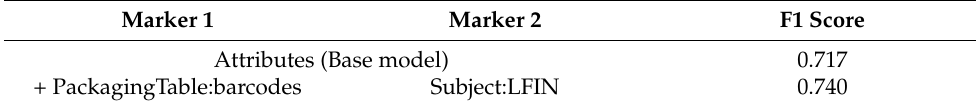
Table 7. Greedy feature selection results (RF, distance features).